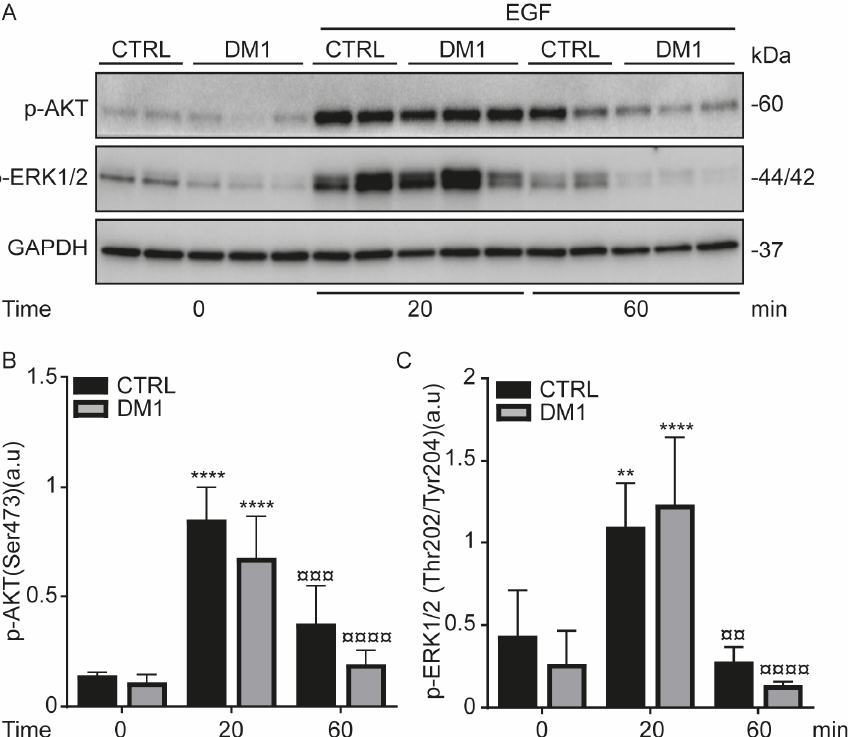
Figure 6. EGF-induced EGFR activation increases AKT/ERK signaling in DM1. ( A – C ) Serum-starved CTRL and DM1 cells were stimulated with 100 ng/mL EGF for 20 min and 60 min. Densitometries of p-AKT ( A , B ) and p-ERK1/2 ( A , C ) were normalized to GAPDH. Values are the mean ± SD of two replicates (** p < 0.01, **** p < 0.0001 versus time zero and ¤¤ p < 0.01, ¤¤¤ p < 0.001, ¤¤¤¤ p < 0.0001 versus 20 min with two-way ANOVA-Tukey’s